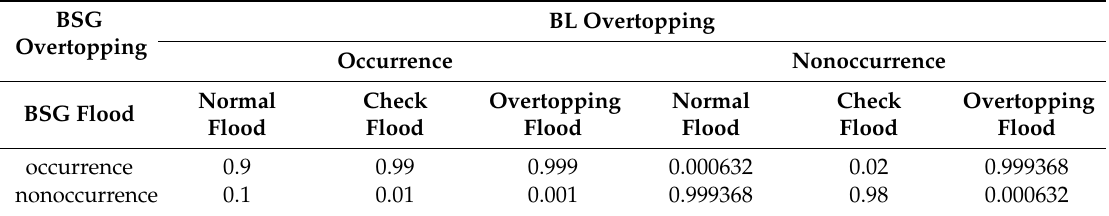
Table 10. The probability of BSG Overtopping on the condition of BL Overtopping and BSG Flood.